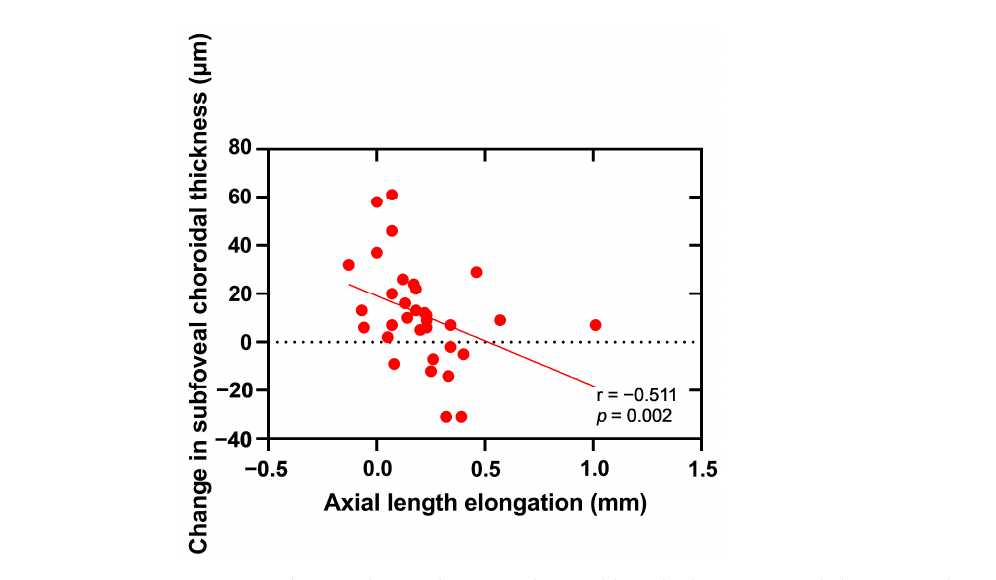
Figure 5. The correlations between the axial length elongation and changes in the subfoveal thickness at twelve-month follow-up.